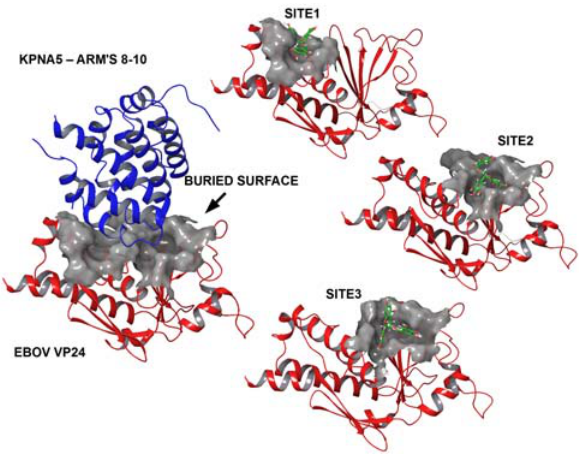
Figure 4: Detection of binding sites based on the interaction bet- ween EBOV VP24 protein and KPNA5.